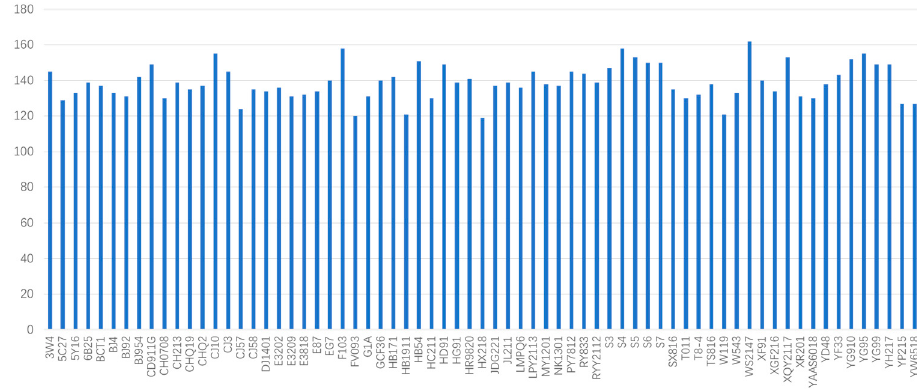
Figure 1. Distribution of the number of detected MNP markers in Flammulina filiformis strains.